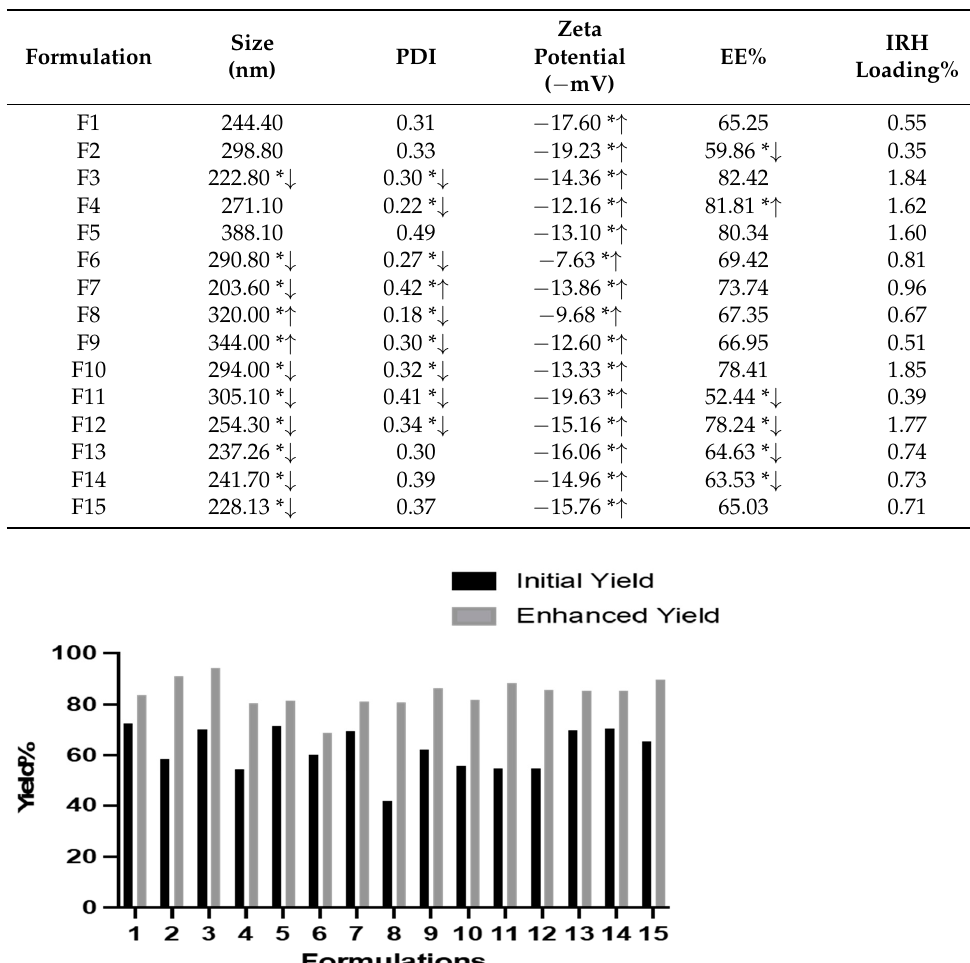
Table 4. Mean size, PDI, zeta potential, EE%, and IRH loading% of NPs after yield enhancement. * indicates significance, while the arrow indicates either an increase ( ↑ ) or decrease ( ↓ ) compared to the data in Table 3.